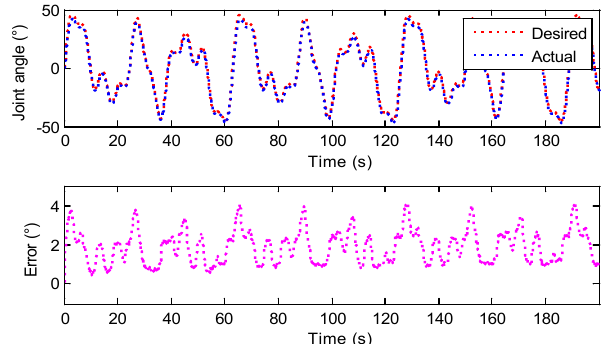
Figure 10. The performance of the control system without a joint angle